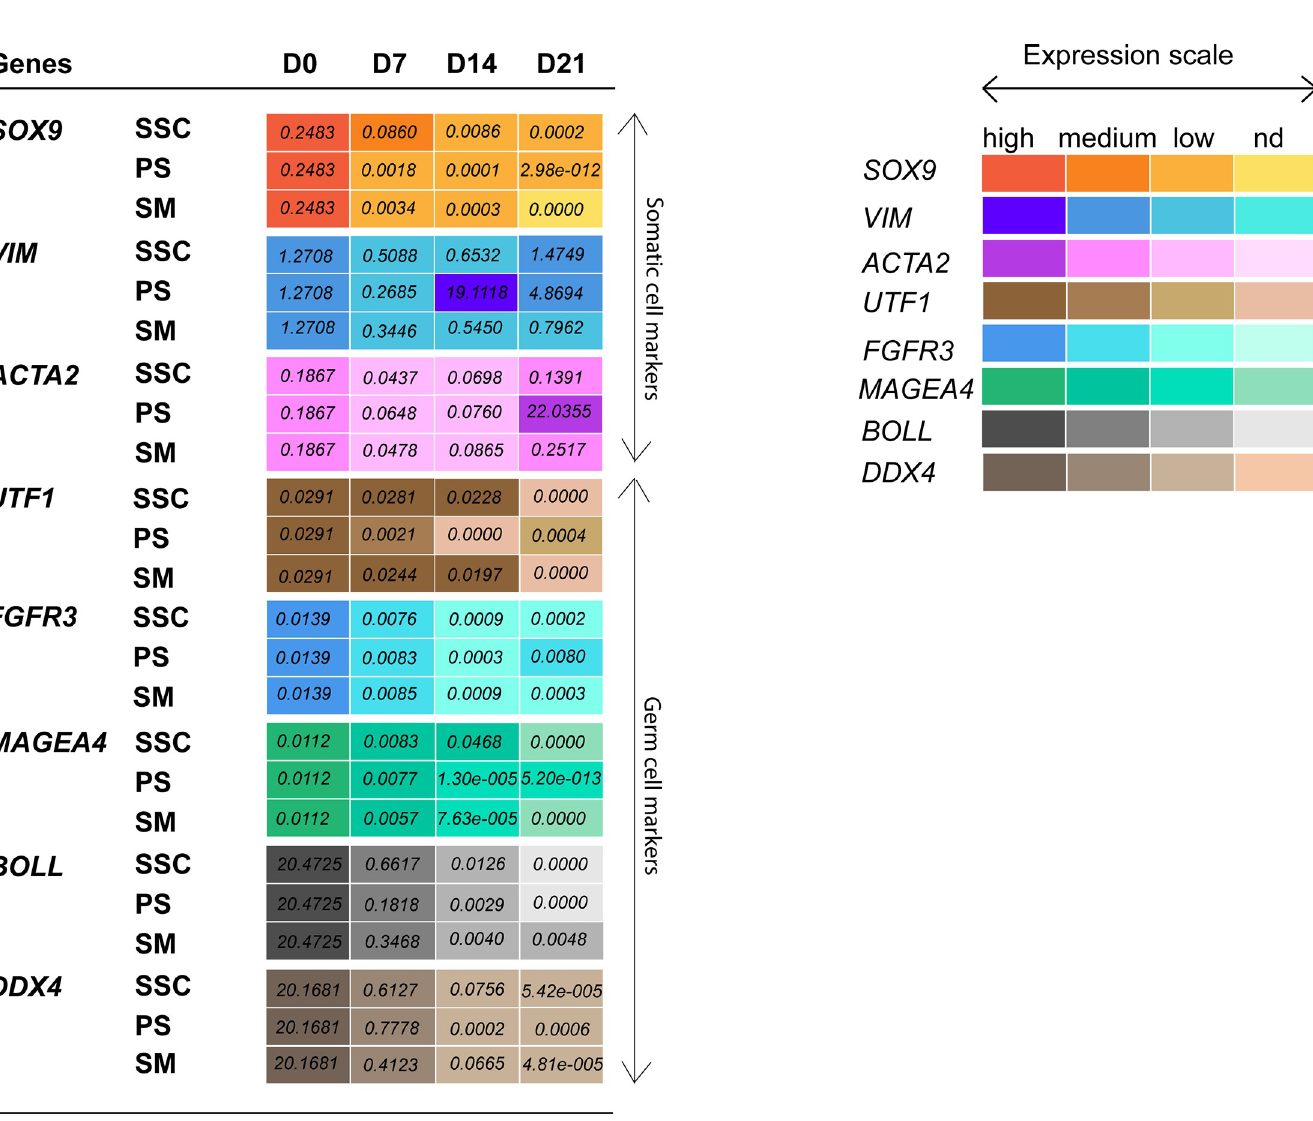
Fig 3. Heat map showing gene expression levels (2^ delta Ct values) of somatic marker genes ( SOX9 , VIM and ACTA2 ) and germ cell marker genes ( UTF1 , FGFR3 , MAGEA4 , BOLL and DDX4 ) relative to reference gene GAPDH of macaque testicular cells cultured in SSC, PS and SM media conditions for 21 days. Expression scale for each marker gene represents relative gene expression levels from high to medium, low and non-detected (nd). Each box represents mean values calculated from cultured testicular cells of 4 macaque monkey